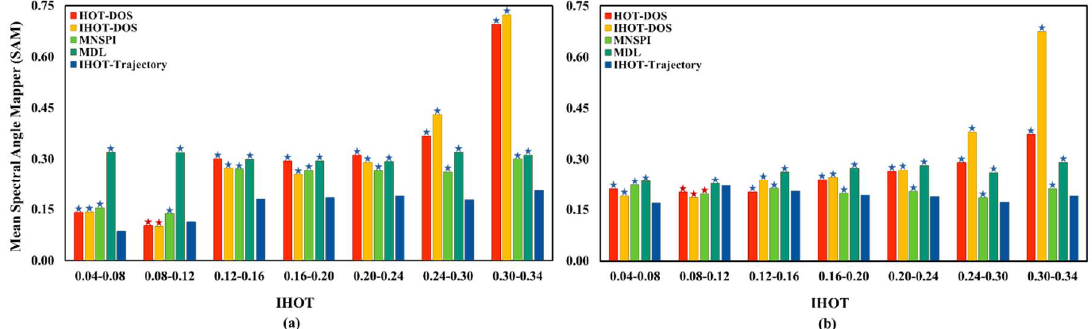
Figure 9. Mean spectral angle mapper (SAM) between the reference image and the restored image using HOT-DOS, IHOT-DOS, IHOT-Trajectory, MNSPI and MDL. ( a ) Mean SAM of the regions of Figure 5b,c and ( b ) mean SAM of the regions Figure 6b,c.